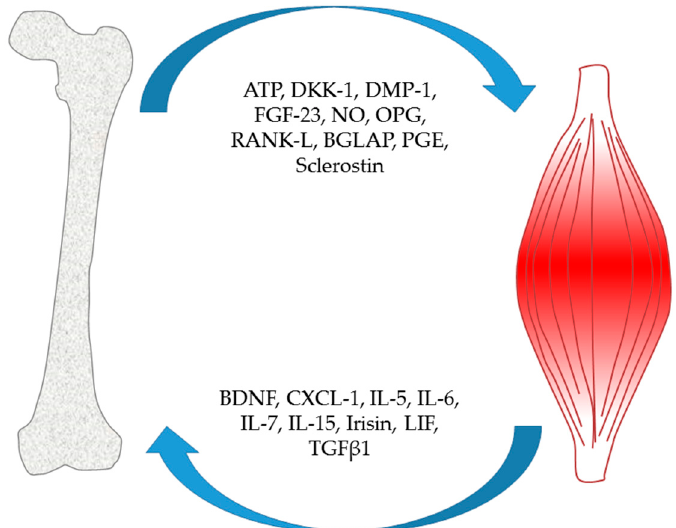
Figure 1. Muscle and bone interaction. Muscle and bone represent two endocrine organs that communicate with each other by the secretion of soluble factors. Factors released from the bone that influence muscle function: ATP (adenosine triphosphate); DKK-1 (Dickkopf-1); DMP-1 (dentin matrix acidic phosphoprotein 1); FGF-23; NO (nitric oxide); OPG (osteoprotegerin); RANKL; BGLAP (gamma-carboxyglutamic acid-containing protein) osteocalcin; PGE (prostaglandins); sclerostin. Muscle is able to stimulate bone by brain-derived neurotrophic factor (BDNF), CXCL1 (chemokine (C-X-C motif) ligand 1), interleukins, irisin, LIF (leukemia inhibitory factor) and TGF β 1. Skeletal muscle, as an endocrine organ, as well as bone produce several secreted factors referred to as myokines. This list of molecules includes myostatin, IL-6 (interleukin 6), IL-8, IL-15, LIF